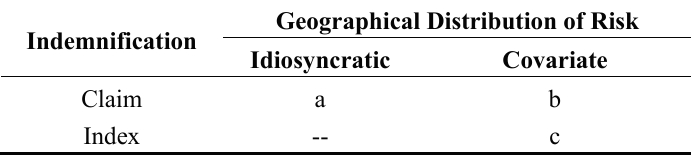
Table 1. Classification of insurance according to indemnification and distribution of